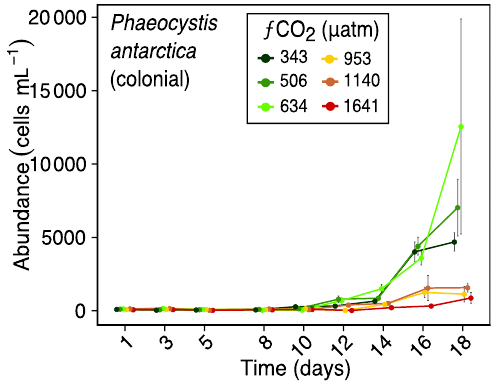
Figure 7. Abundance of Phaeocystis antarctica (colonial form) over days 1 to 18 of the incubation of a natural protistan commu- nity in tanks maintained at different f CO 2 levels. Error bars are standard errors derived from pseudo-replicates undertaken at each time point for each